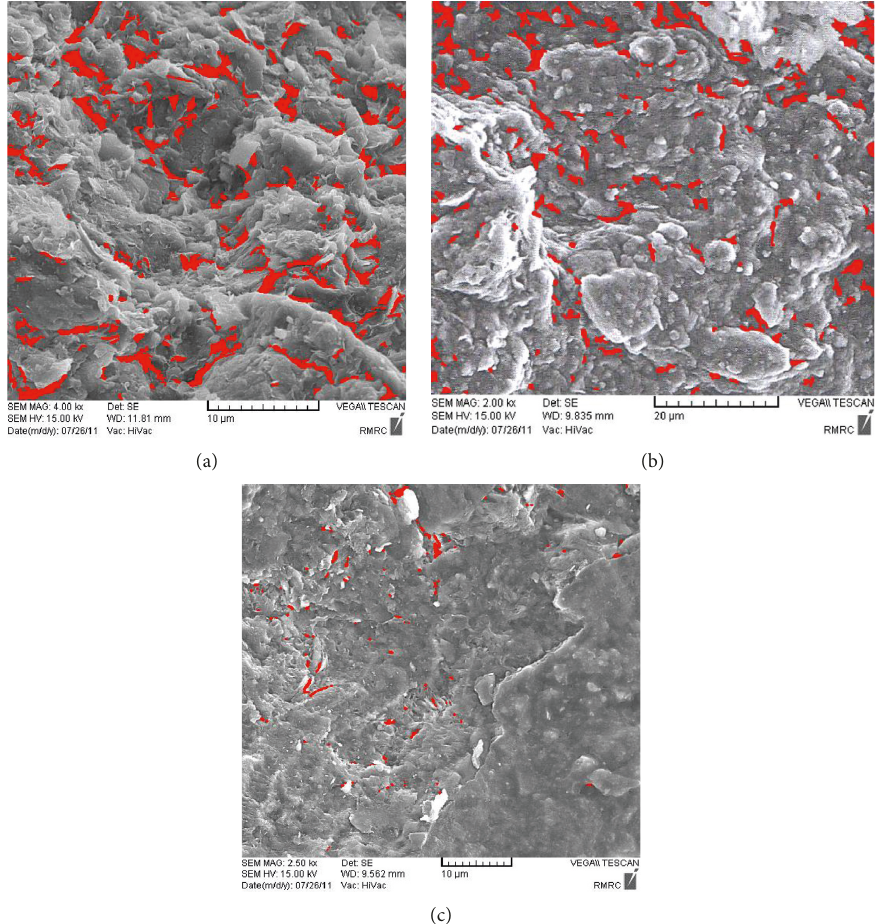
Figure 11: SEM micrographs: (a) the high-plasticity clay soil, (b) 6% lime +1.5 nano-ZnO, and (c) 6% lime +2%